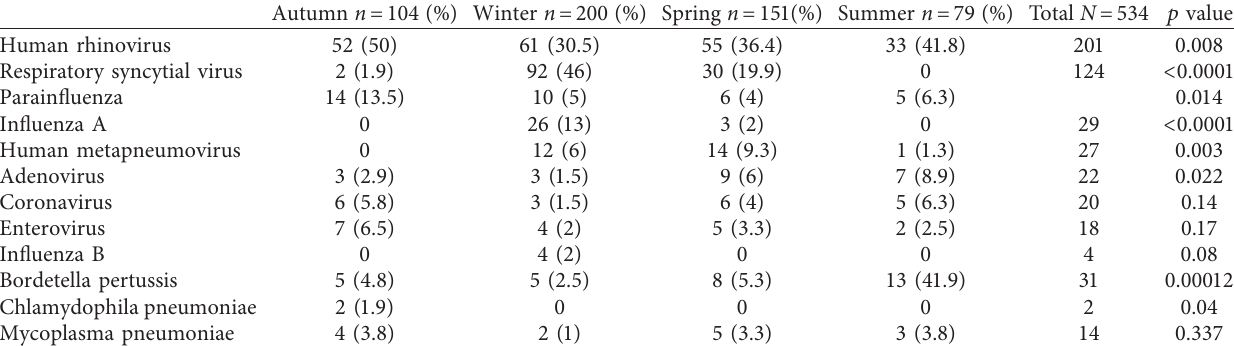
Table 5: Prevalence of respiratory pathogens in